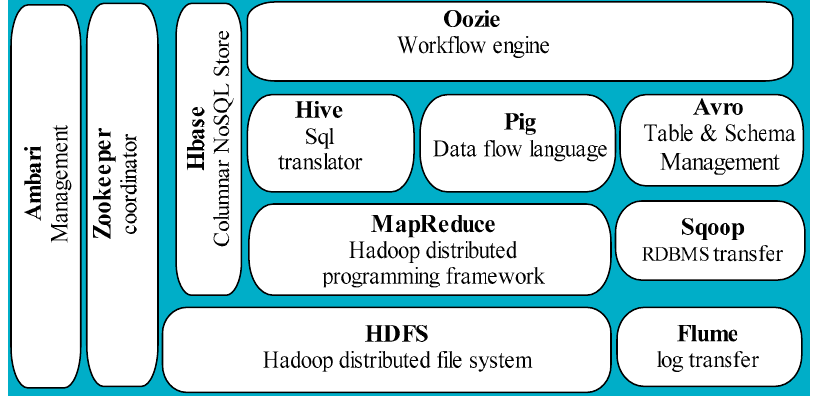
Figure 7. Common tools used in a Hadoop cluster.